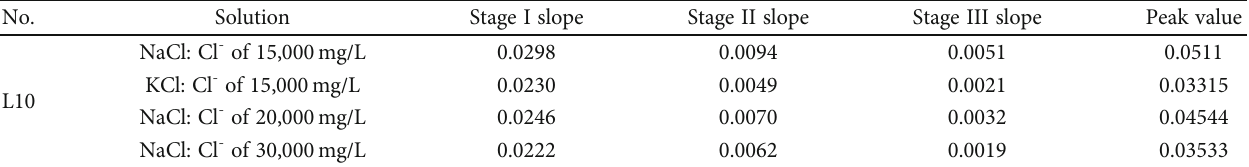
Table 3: Parameters of imbibition curves of the deep shale samples in di ff erent salt